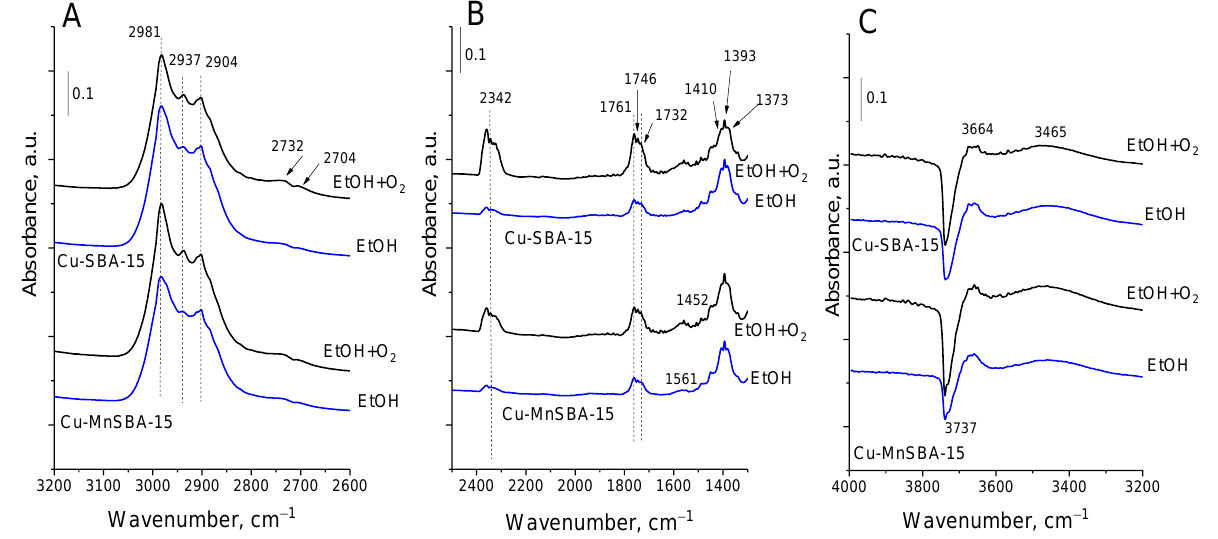
Figure 9. A comparison of the FTIR spectra recorded in ethanol (blue) and ethanol with oxygen (black) flow at 473 K after 45 min of the dehydrogenation reaction for Cu-SBA-15 and Cu-MnSBA-15 materials: ( A ) 3200 – 2600 cm −1 range; ( B ) 2500 – 1300 cm −1 range; ( C ) 4000 – 3200 cm −1 range.